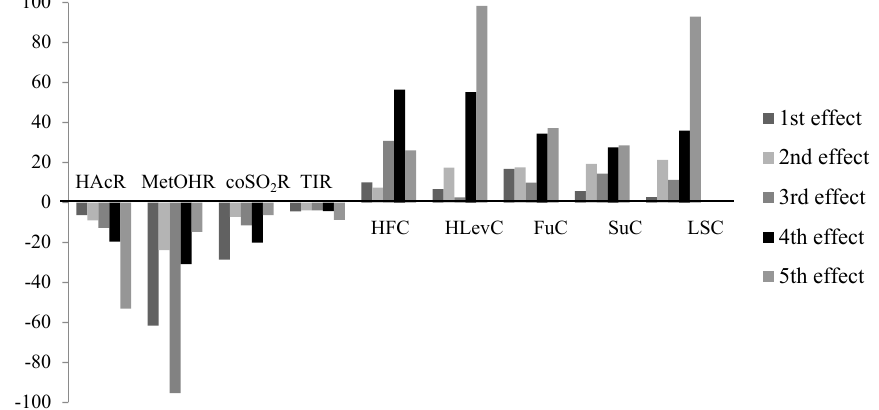
Figure 1. Results of inhibitors and sugars of SSL within the five evaporation effects.